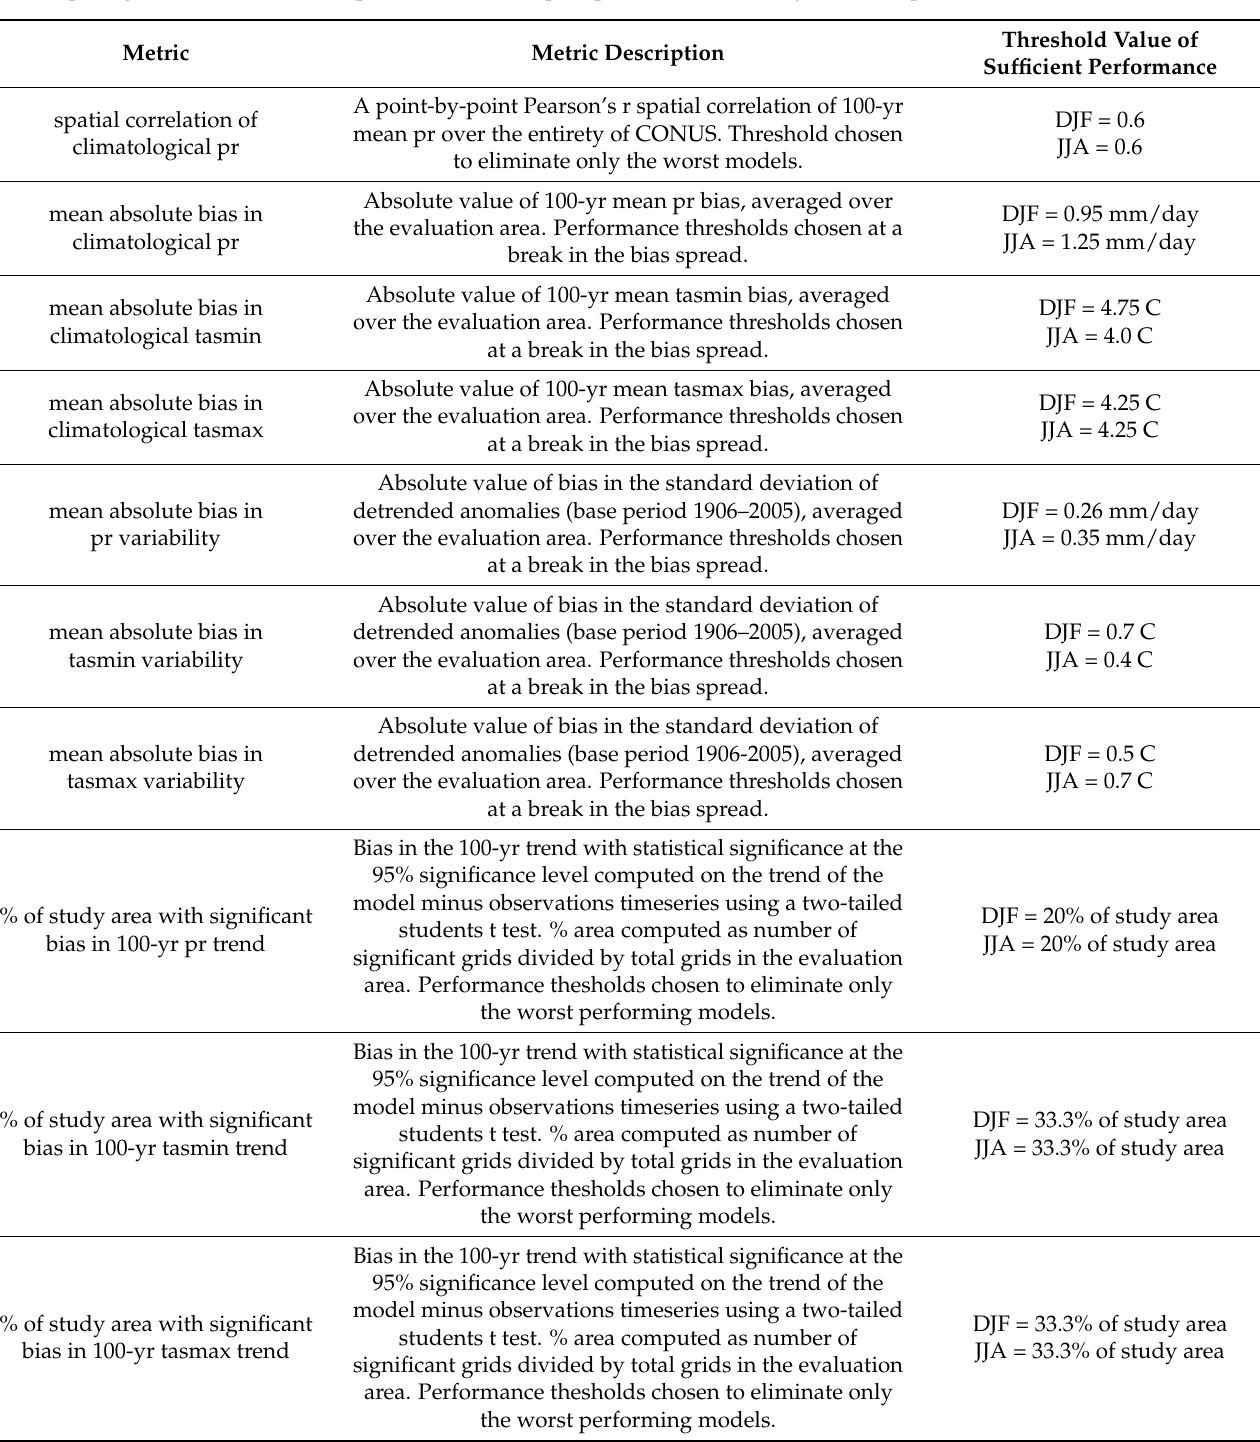
Table A1. The 10 metrics and metric threshold values used to determine GCM performance. Metrics were designed to test GCM performance in variables previously determined to be important to historical occurrences of the VS virus; namely winter (DJF) and summer (JJA) precipitation (pr), and minimum and maximum surface air temperature (tasmin, tasmax). All metrics were computed for winter (DJF) and summer (JJA) seasonal averages over the 100-year period 1906–2005 by comparing the GCM historical experiment to GPCC precipitation and Berkeley Earth temperature